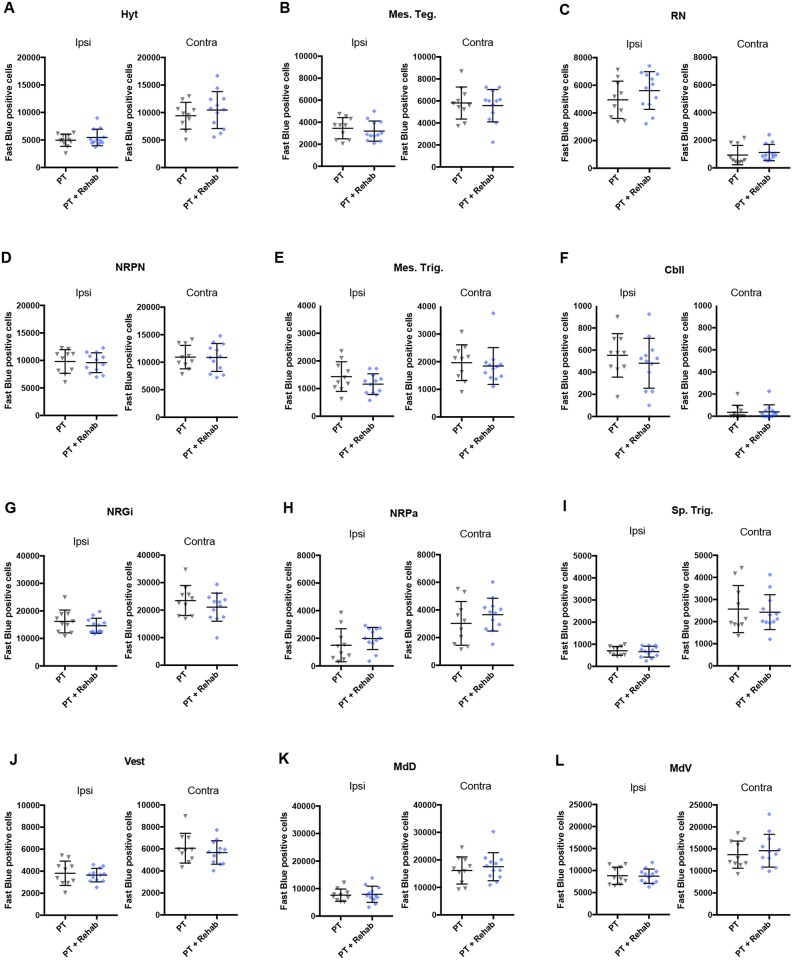
The effect of skilled forelimb training on the spinal projections from the brainstem.The numbers of Fast blue-positive cells were analyzed in the (A) Hypothalamic area (Hyt), (B) mesencephalic tegmental area (Mes. Teg.), (C) red nucleus (RN), (D) nucleus reticularis pontis (NRPN) (E) mesencephalic trigeminal nuclei (Mes. Trig.), (F) deep cerebellar nuclei (Cbll), (G) nucleus reticularis gigantocellularis (NRGi), (H) nucleus reticularis parvocellularis (NRPN), (I) spinal trigeminal nuclei (Sp. Trig.), (J) vestibular nuclei (Vest), (K) dorsal medullary reticular nucleus (MdD), and (L) ventral medullary reticular nucleus (MdV). Rehabilitative skilled forelimb training did not induce significant changes in any areas of the hypothalamus, midbrain, pons, cerebellum, or medulla oblongata.